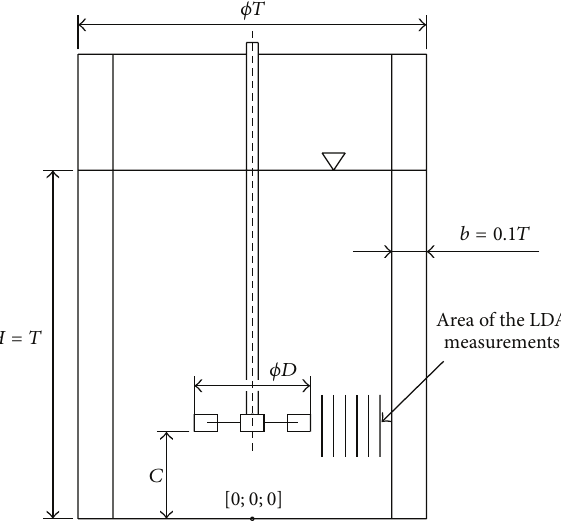
Figure 4: Pilot plant cylindrical vessel with a six-blade Rushton turbine ( 𝑇 = 300 mm, 𝐻/𝑇 = 1 , 𝐶/𝐷 = 0.75 , 𝑏/𝑇 = 1/10 , four